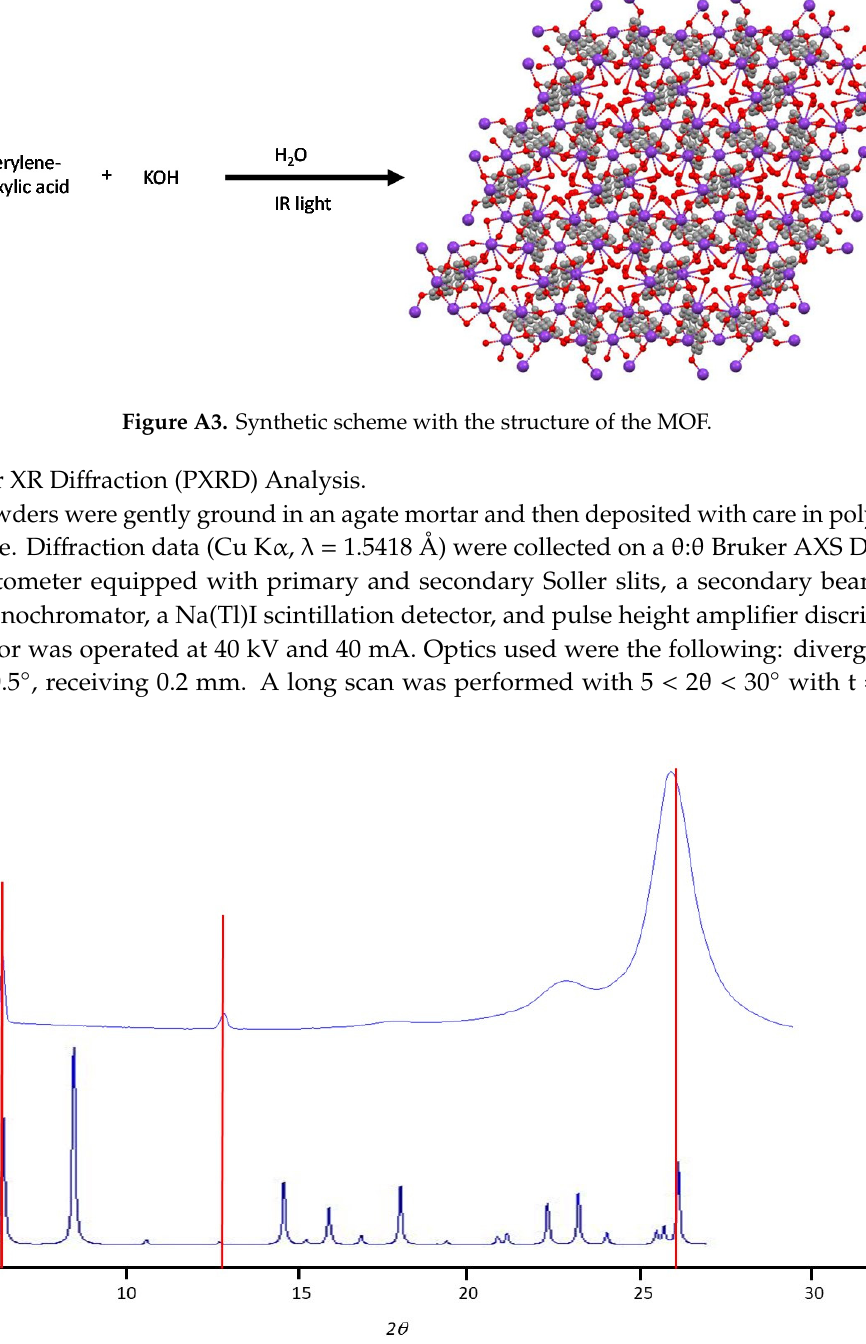
Figure A4. Top: Experimental PXRD of sample after spray coating deposition. Down: Theoretical PXRD obtaining of single crystal data.